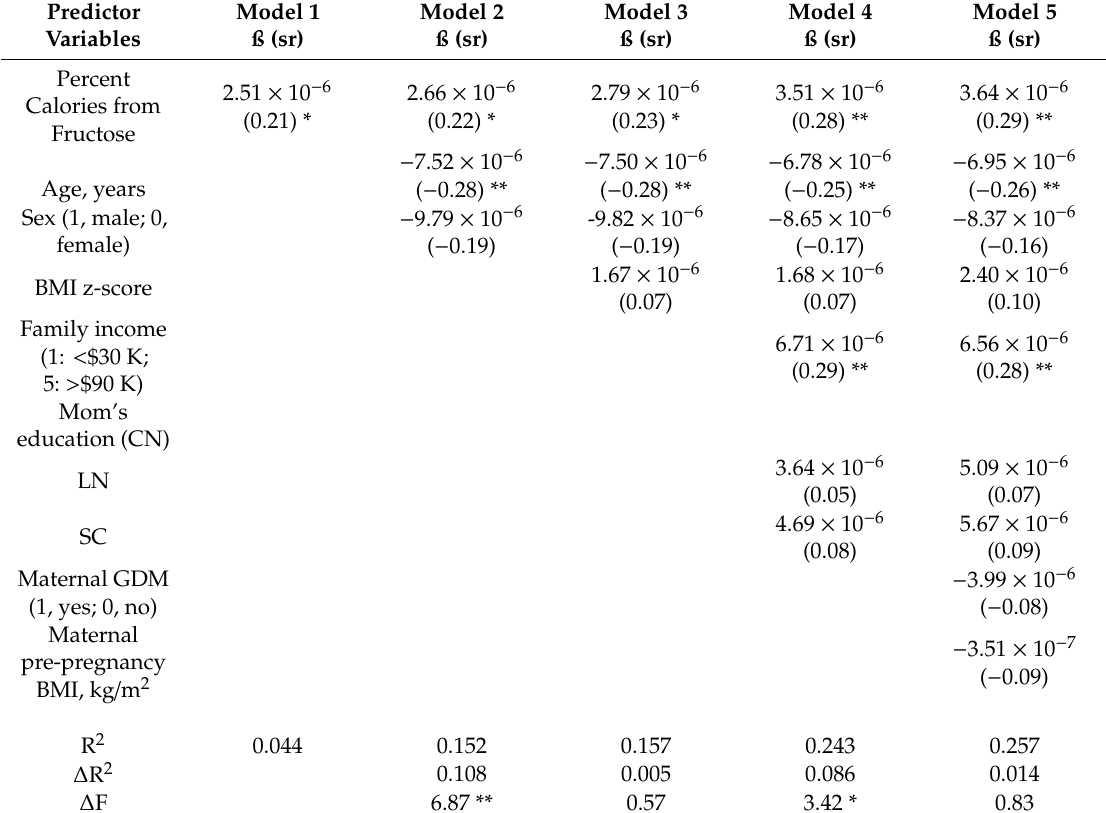
Table 4. Effects of fructose consumption on the mean diffusivity (MD) of right cingulum, prefrontal